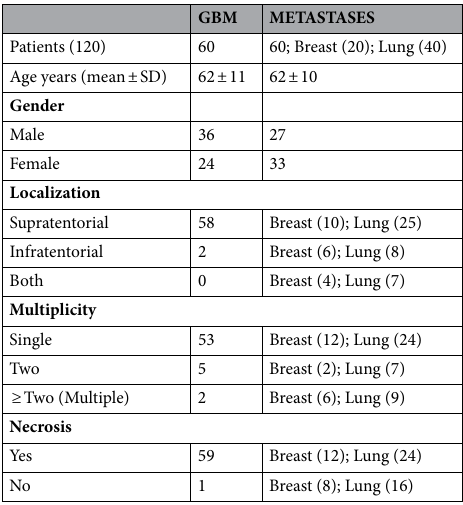
Table 1. Patient demographics and tumor characteristics.